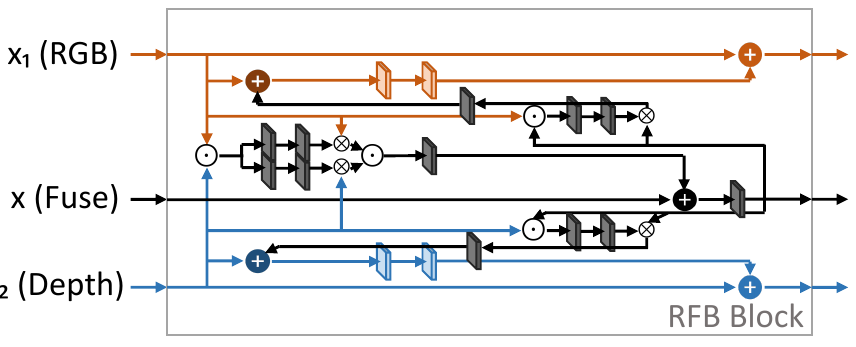
Figure 7. Architecture of the modified version of SSMA proposed by [104].